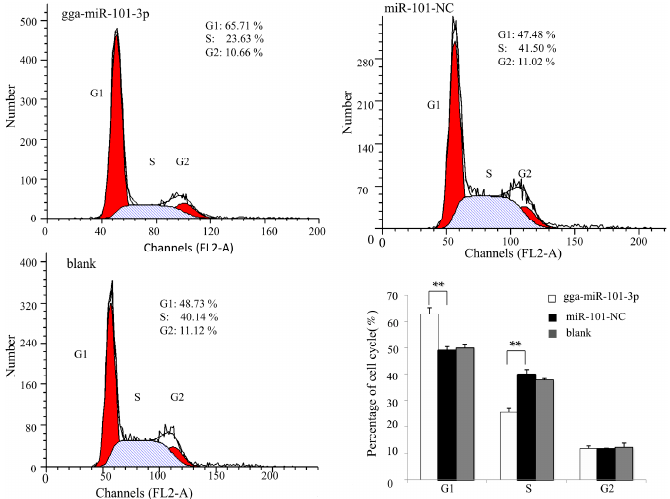
Figure 6. Over-expression of gga-miR-101-3p arrested DF1 cells at G1 phase. The DF-1 cells were transfected with gga-miR-101-3p or the negative control. A mock transfection was also performed as blank control. At 48 h of post-transfection, the cell phase distribution was analyzed by flow cytometry. Three independent experiments were performed in triplicate. Data are presented as means ± SD. Two-tailed Student’s t -test was used to analyze significant differences (** p < 0.01).